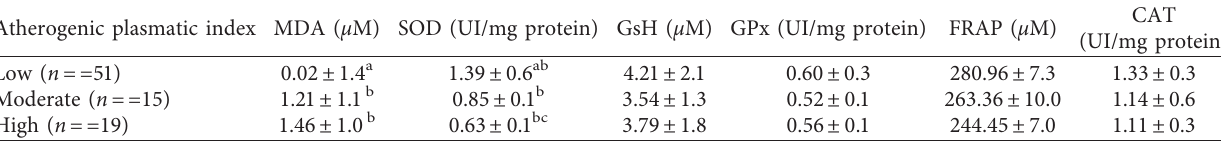
Table 4: Relation between atherogenic plasmatic index and markers of oxidative stress.